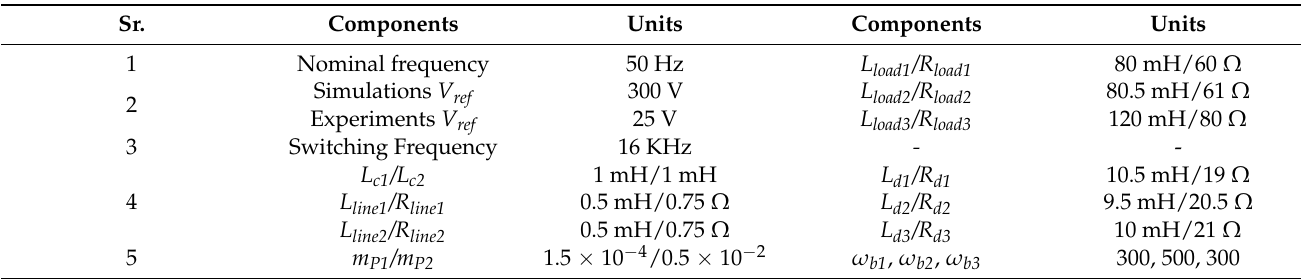
Table 1. System parameters for simulation and experiment.